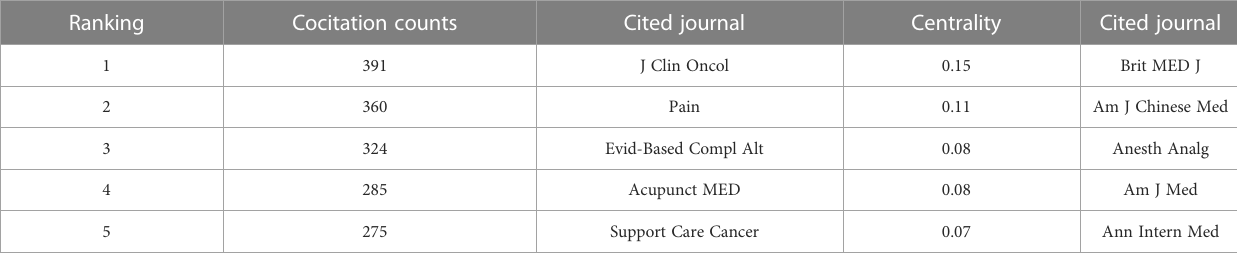
TABLE 7 Top 5 cited journals with the highest frequency and centrality related to studies on acupuncture for cancer pain. Ranking Cocitation counts